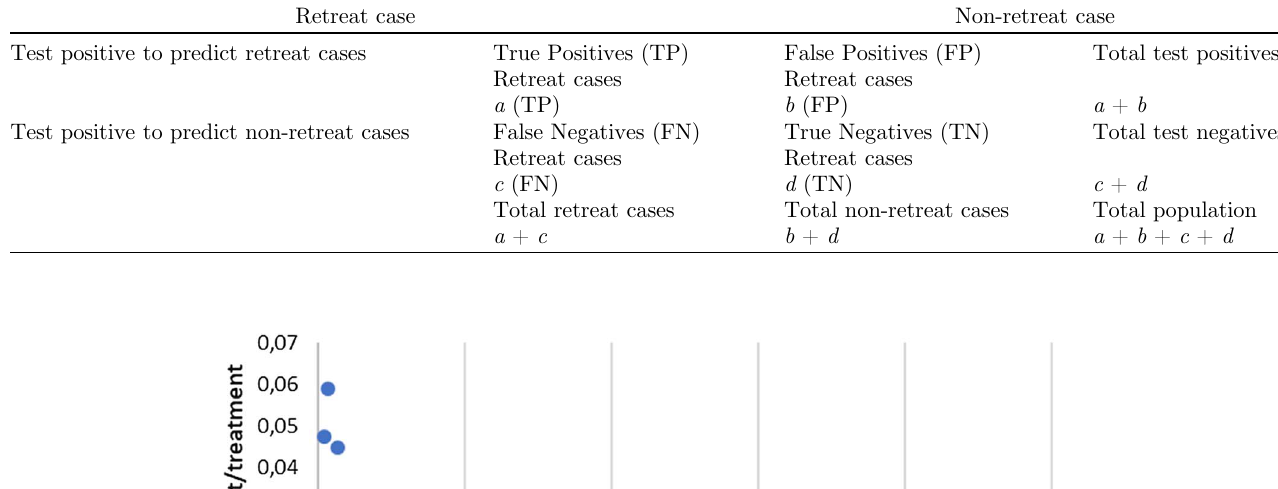
Table 4. Terms of the sensitivity and speci fi city measurements.